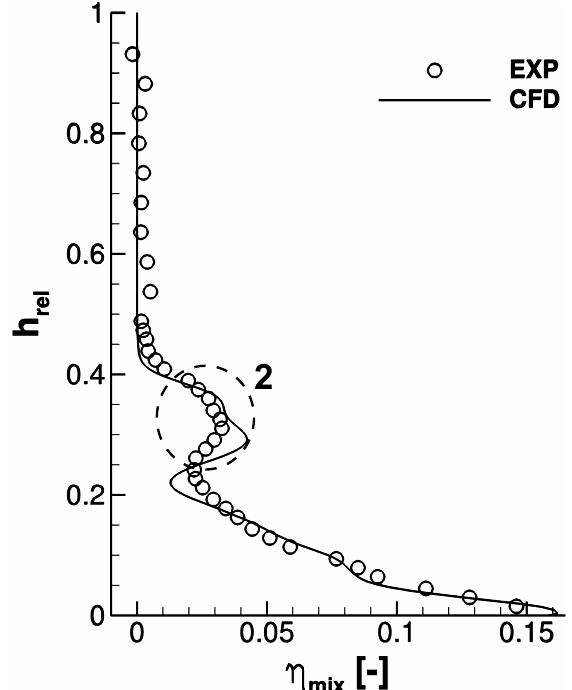
Figure 7. Comparison of circumferentially, area-averaged mixing effectiveness η mix of measurements and Computational Fluid Dynamics (CFD) in ME02.